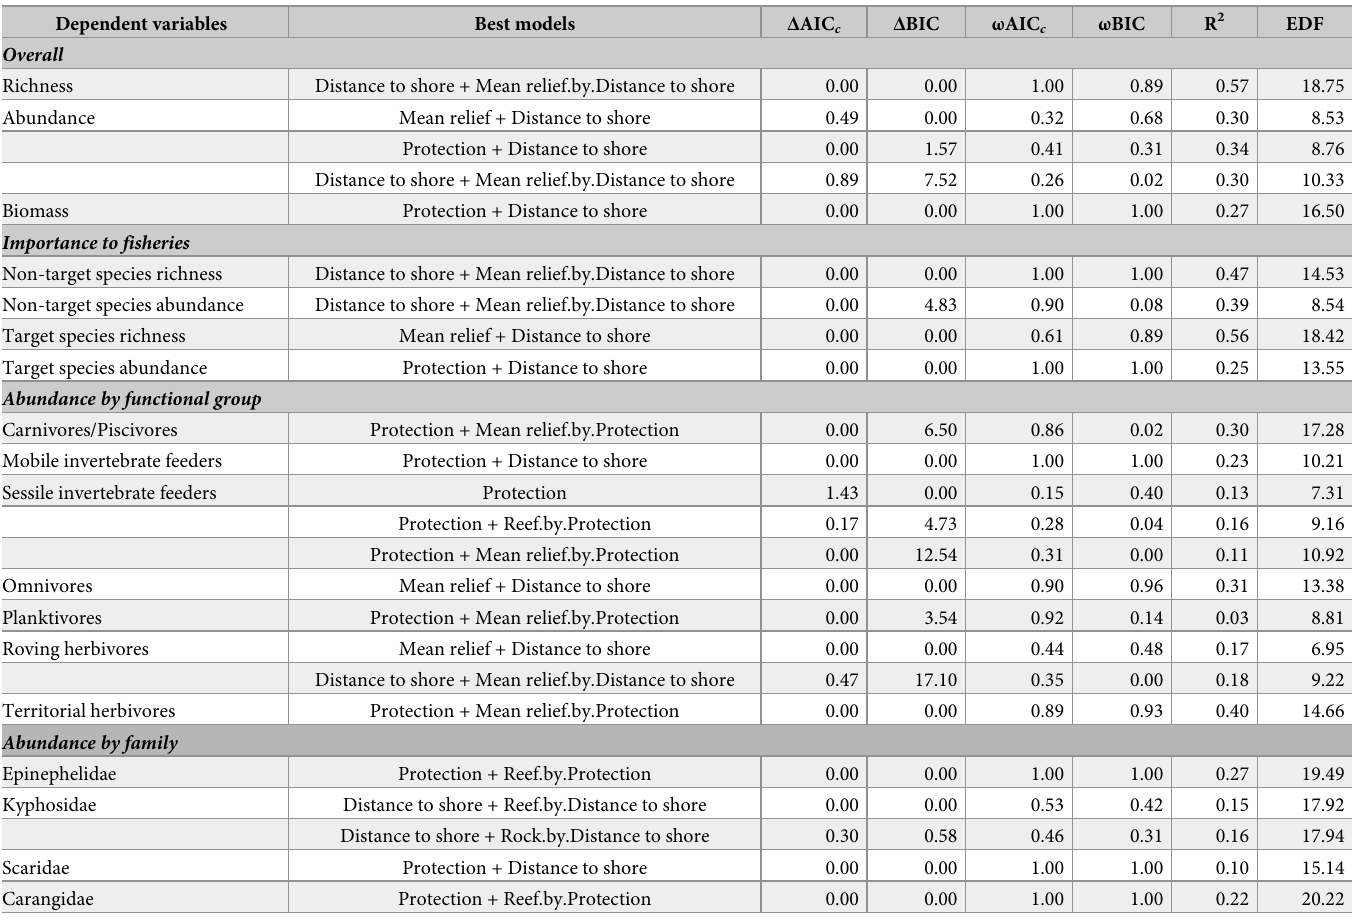
Table 3. Top generalised additive mixed models (GAMMs) to predict different aspects of fish